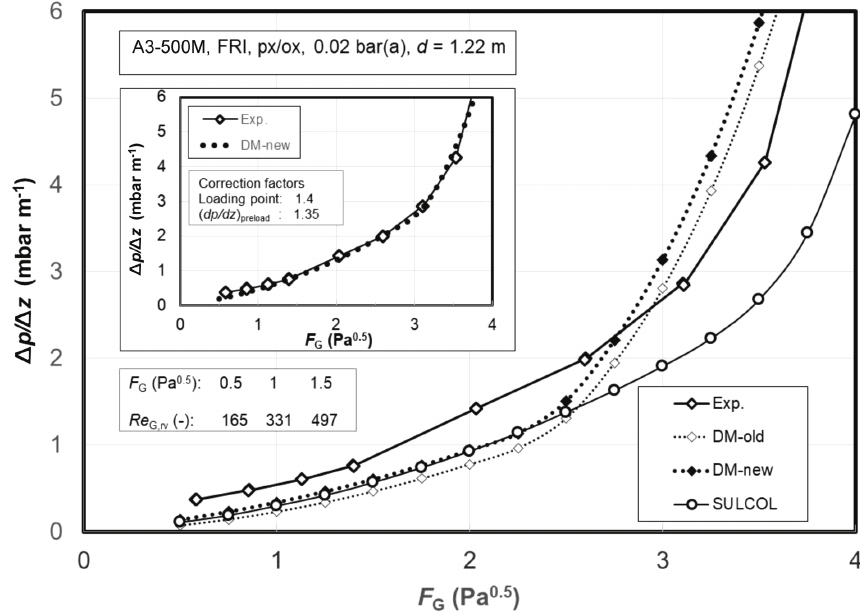
Fig. 15 – Comparison of the specific pressure drop as estimated by original (DM-old) and extended DM (DM-new) for advanced wire gauze corrugated sheet structured packing A3-500M compared with experimental data (FRI, 0.02 bar). SULCOL estimates are related to BXPlus. Inserted graph demonstrates that pressure drop predicted by extended DM utiliz- ing two correction factors, which reflect the extent of deviation in this case, perfectly match- es with